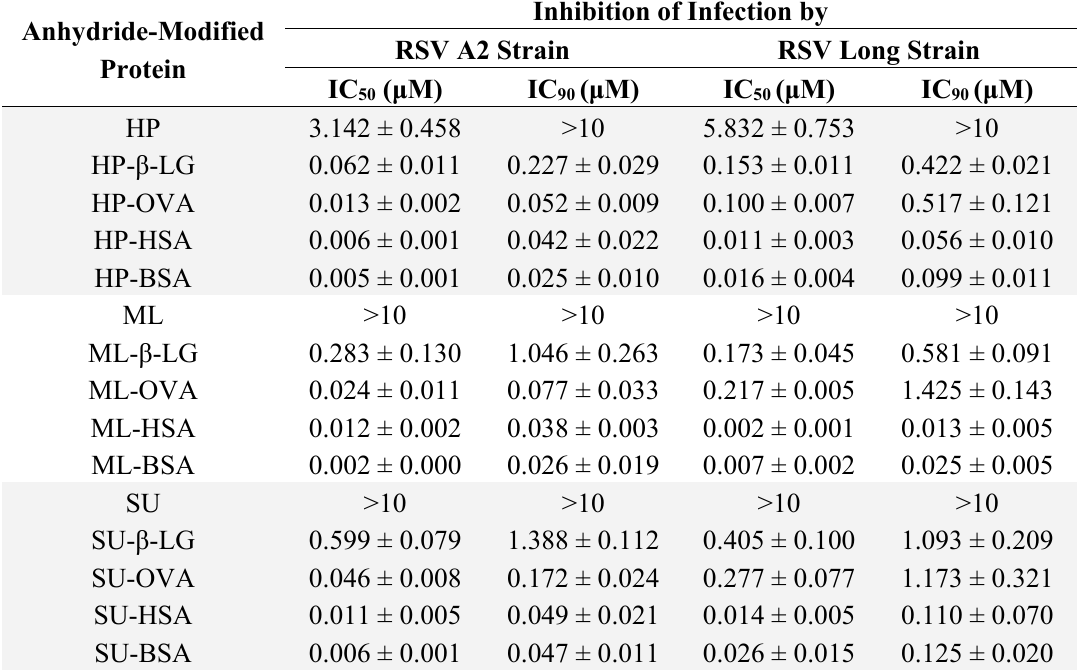
Table 1. Comparison of the anti-respiratory syncytial virus (RSV) activities of different proteins modified by distinct